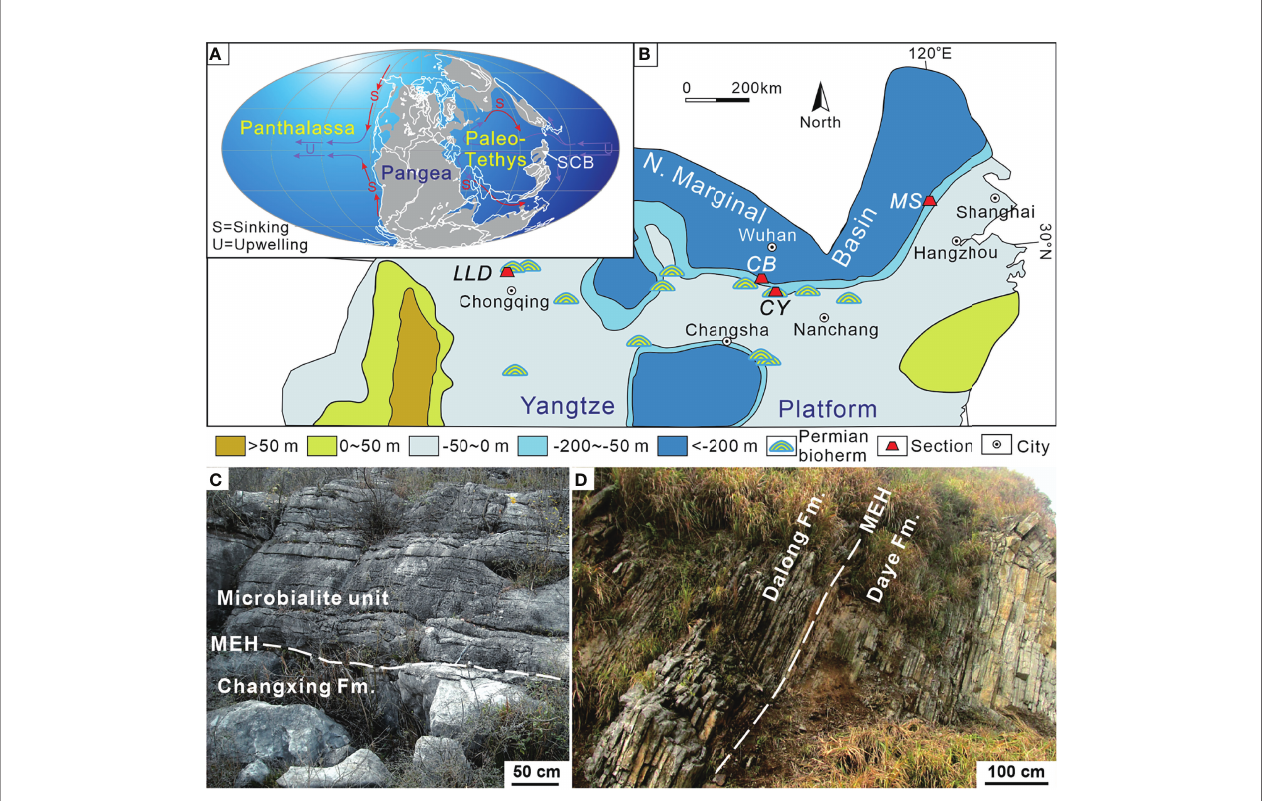
FIGURE 1 | Changhsingian paleogeographic map showing the location of the sections investigated. (A) Global map revised from Scotese (2001). (B) Base map of the South China Block revised from Wang and Jin (2000). (C) Field outcrop of the Chongyang section showing the lower part of the microbialite unit and Late Permian grainstone near the P – Tr boundary. (D) Field outcrop of the Chibi section in Xianning city showing the P – Tr transition sequence. MEH, mass extinction horizon; SCB, South China Block; CB , Chibi section; CY , Chongyang section; LLD , Laolongdong section; MS , Meishan